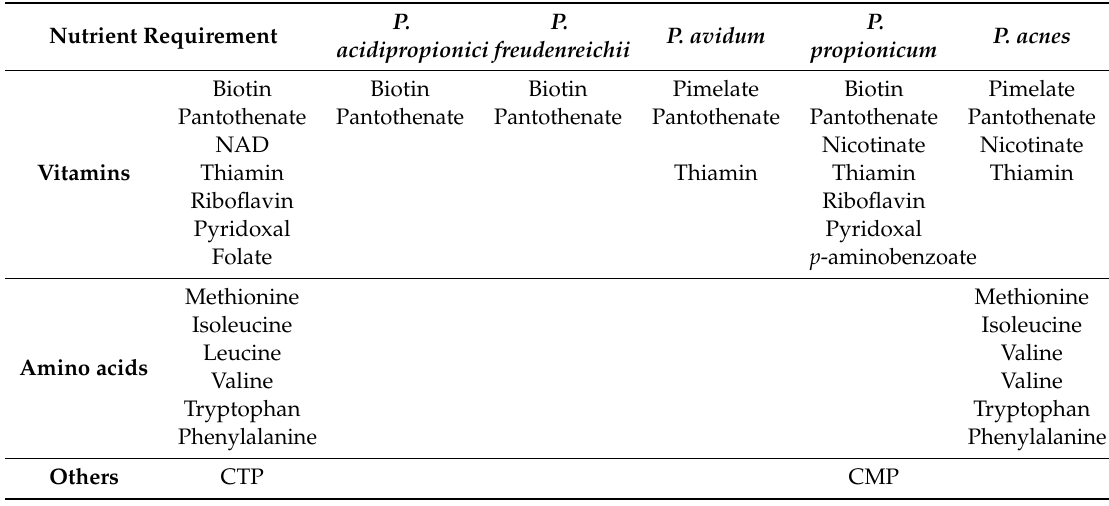
Table 5. Minimal media requirements as determined during the reconstruction